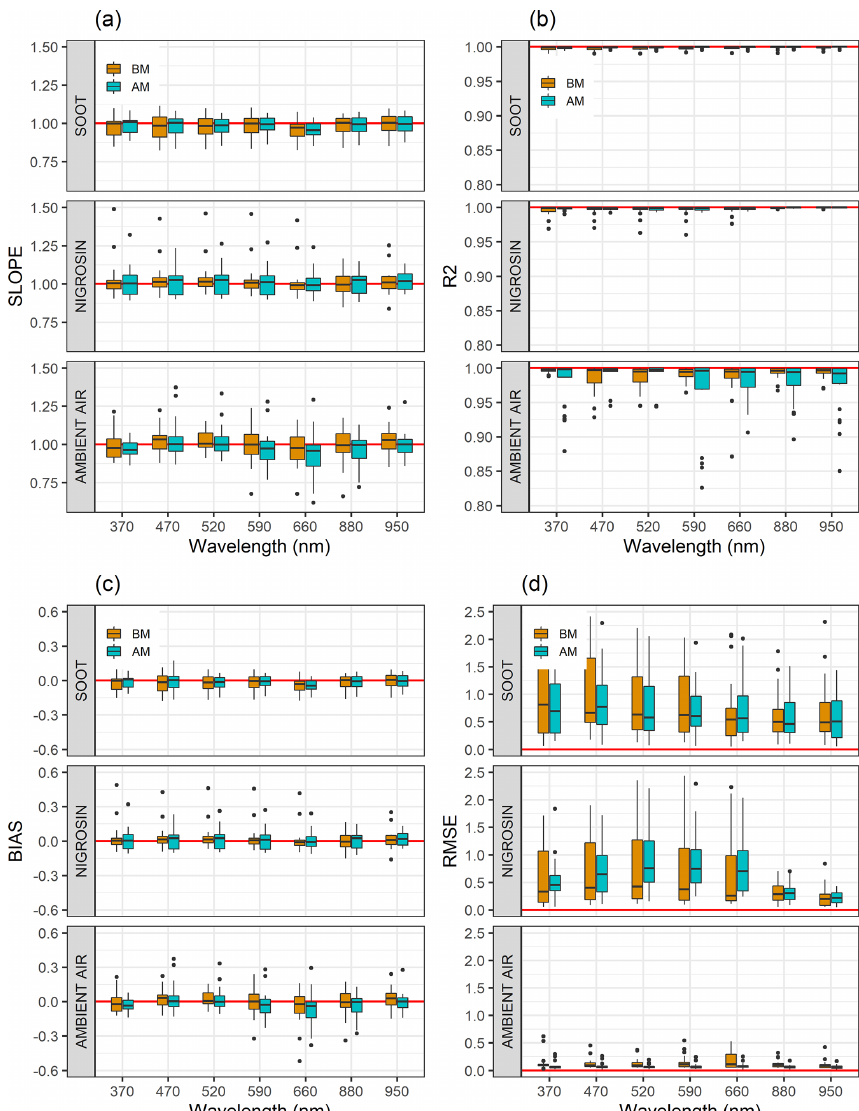
Figure 12. Statistics from the unit-to-unit variabilities of the 23 units intercompared with the reference AE33, as a function of wavelength for soot, nigrosin, and ambient air: (a) slope, (b) R 2 , (c) bias, (d) RMSE. The black horizontal line inside the boxes represents the median value of the slope, R 2 , bias, and RMSE (statistical variables); the lower and upper borders of the boxes are the first and third quartiles, on which the middle 50% of the statistical variables are located; the whiskers correspond to ranges for the bottom 25% and the top 25% without outliers (black points). The red line represents the slope and R 2 equaling 1 (0% of deviation) in the subplots (a, b) and the bias and RMSE equaling 0 in the subplots (b, c) . BM: before maintenance. AM: after